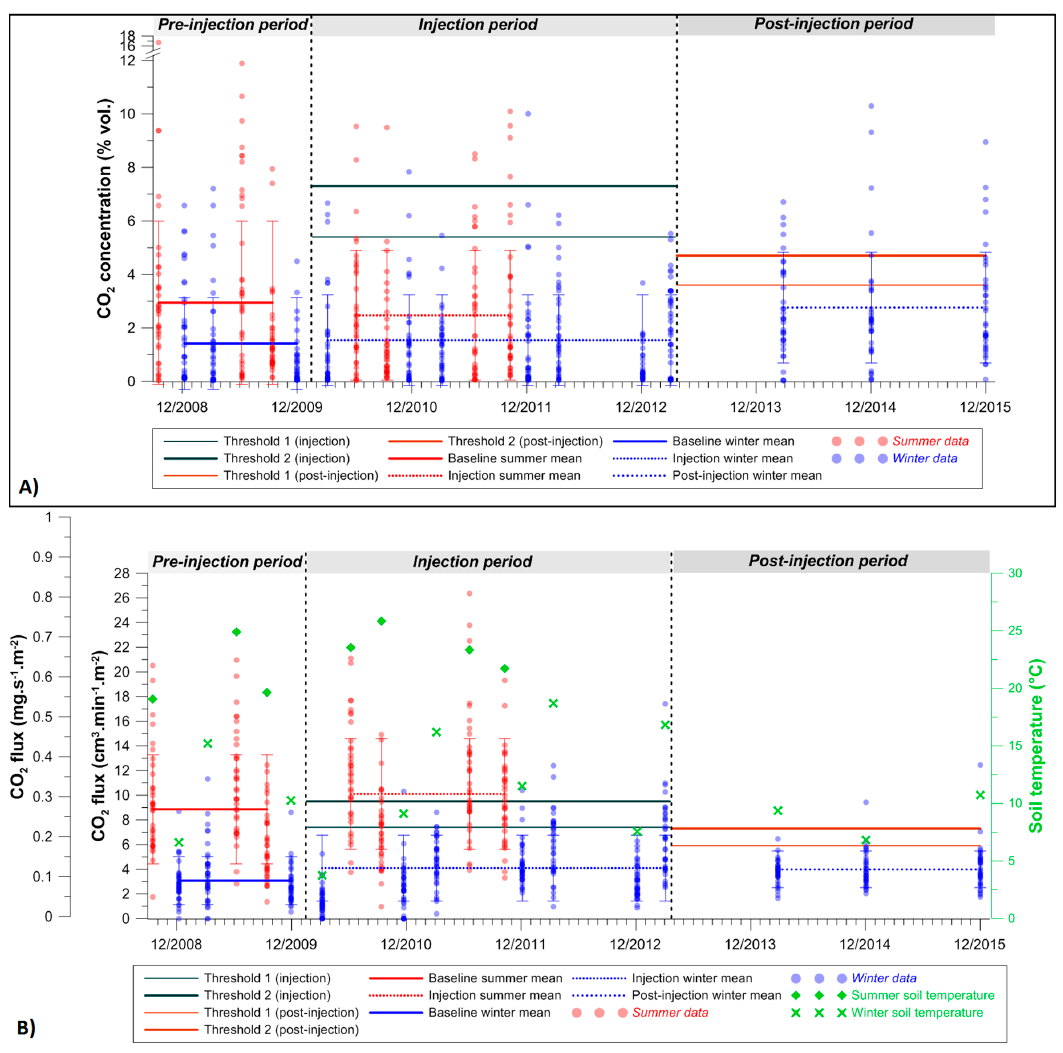
Figure 7. ( A ) CO 2 concentrations as a function of time: winter and summer data are treated separately as a function of the period of site activity (baseline, injection, post-injection). Mean values for each period are indicated (blue and red lines respectively) with error bar corresponding to the standard deviation. Threshold levels in use during injection and post-injection periods are reported for comparison. ( B ) similar plot for CO 2 -fluxes; green points correspond to mean soil temperature at the time of the sampling session.